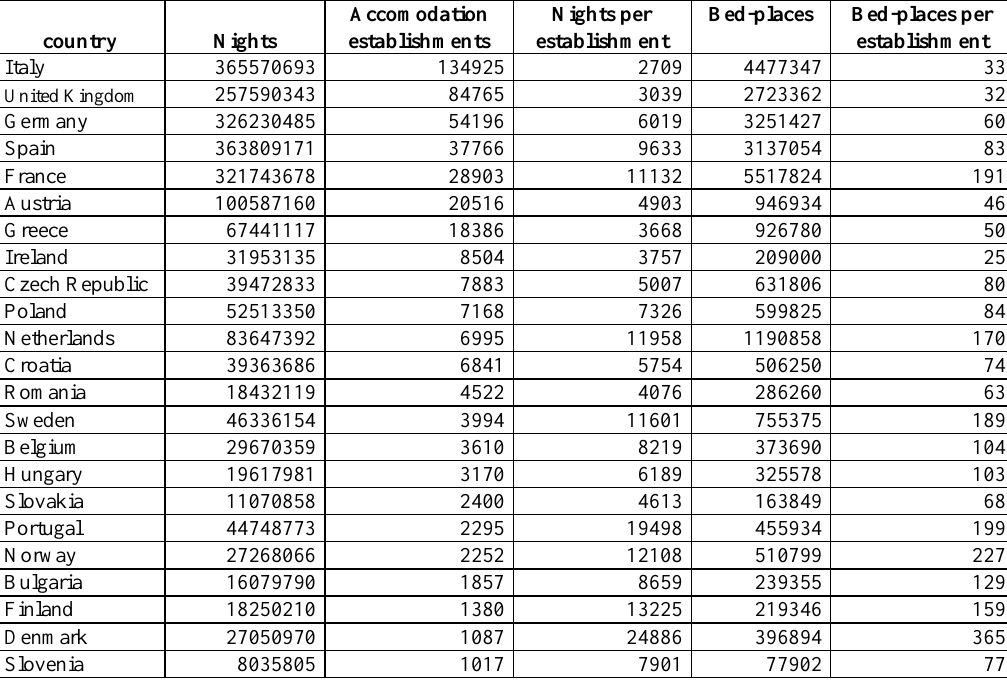
Table 2: Tourism Indicators by European Country (Top 30 rank by number of accommodation establishments; average